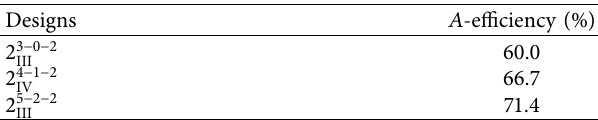
Table 2: Design efciency for m � 3, 4, and 5 with 4 choice sets of size